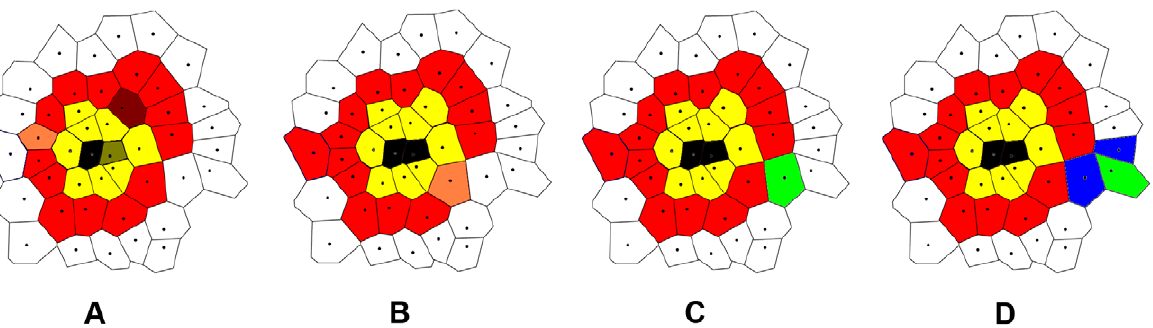
Figure 3. Illustration of cellular automaton rules. Necrotic cells are black, quiescent cells are yellow, proliferative cells are red and invasive tumor cells are green. The ECM associated automaton cells are white and the degraded ECM is blue. (a) A proliferative cell (dark red) is too far away from the tumor edge to get sufficient nutrients/oxygen and it will turn quiescent in panel (b). A quiescent cell (dark yellow) is too far away from the tumor edge and it will turn necrotic in panel (b). Another proliferative cell (light red) will produce a daughter proliferative cell in panel (b). (b) The dark red proliferative cell and the dark yellow quiescent cell in panel (a) turned quiescent and necrotic, respectively. The light red proliferative cell in panel (a) produced a daughter cell. Another proliferative cell (light red) will produce a mutant invasive daughter cell. (c) The light red proliferative cell in (b) produced an invasive cell. (d) The invasive cell degraded the surrounding ECM and moved to another automaton cell.